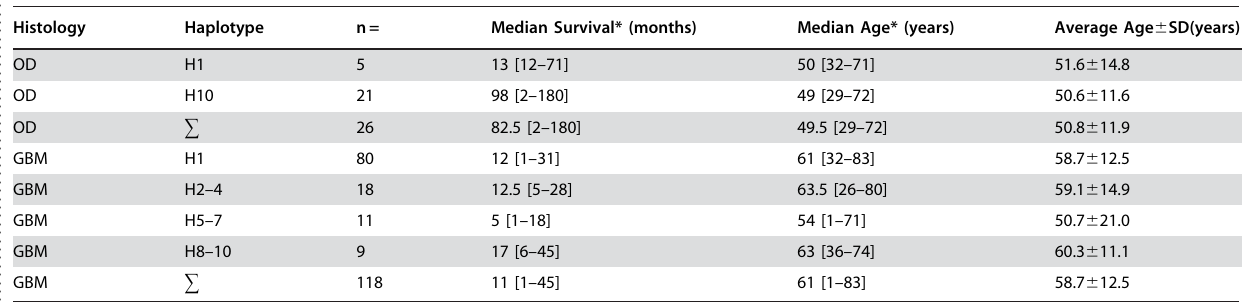
Table 1. Age of glioma patients at diagnosis. .. ... .... ... ... .... ... ... .... ... ... .... ... ... .... ... ... .... ... ... .... ... ... .... ... ... .... ... ... .... ... ... .... ... ... .... ... ... .... ... ... .... ... ... .